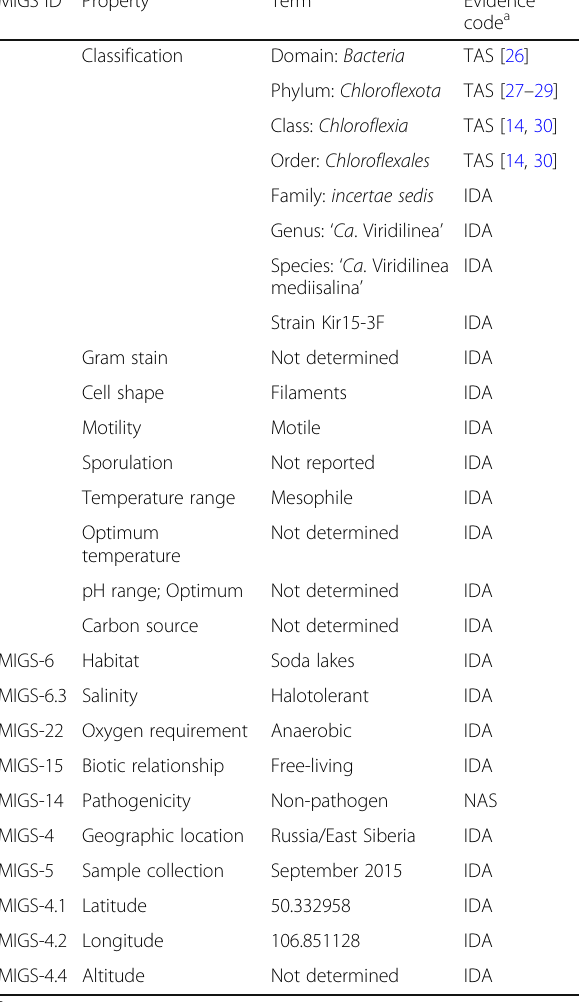
Table 2 Classification and general characteristics of ‘